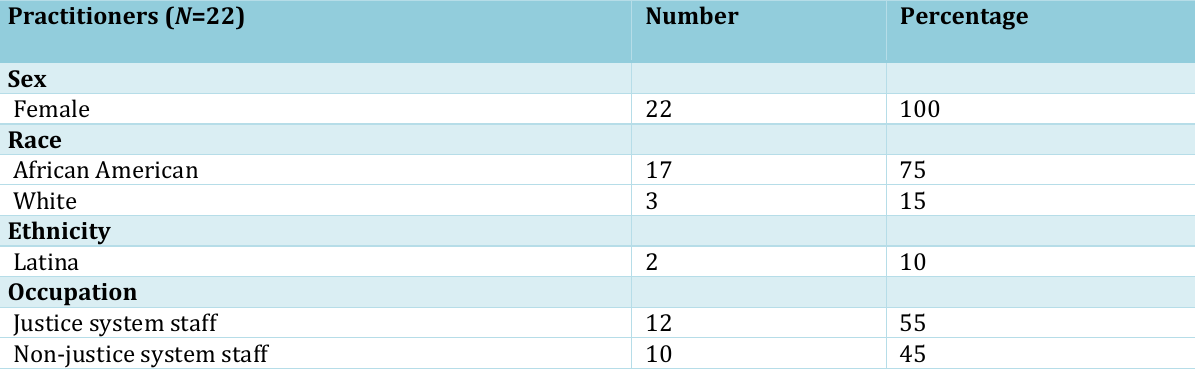
Table 3. Practitioner demographics Practitioners ( N